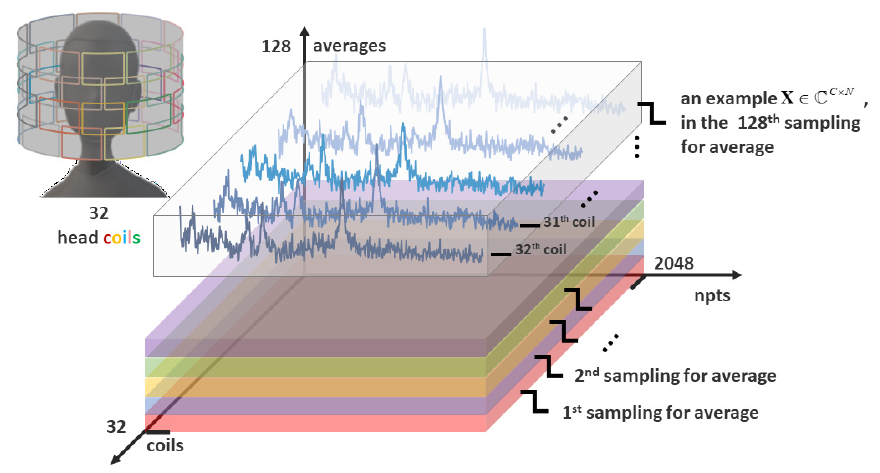
Figure 1. An illustration of the array coil acquisition with repeatedly sampled, three-dimensions ~ × × ∈ X   data acquisition C A N (coils ( C ), averages ( A ), npts ( N )). data acquisition X ∈ C C × A × N (coils ( C ), averages ( A ), npts ( N